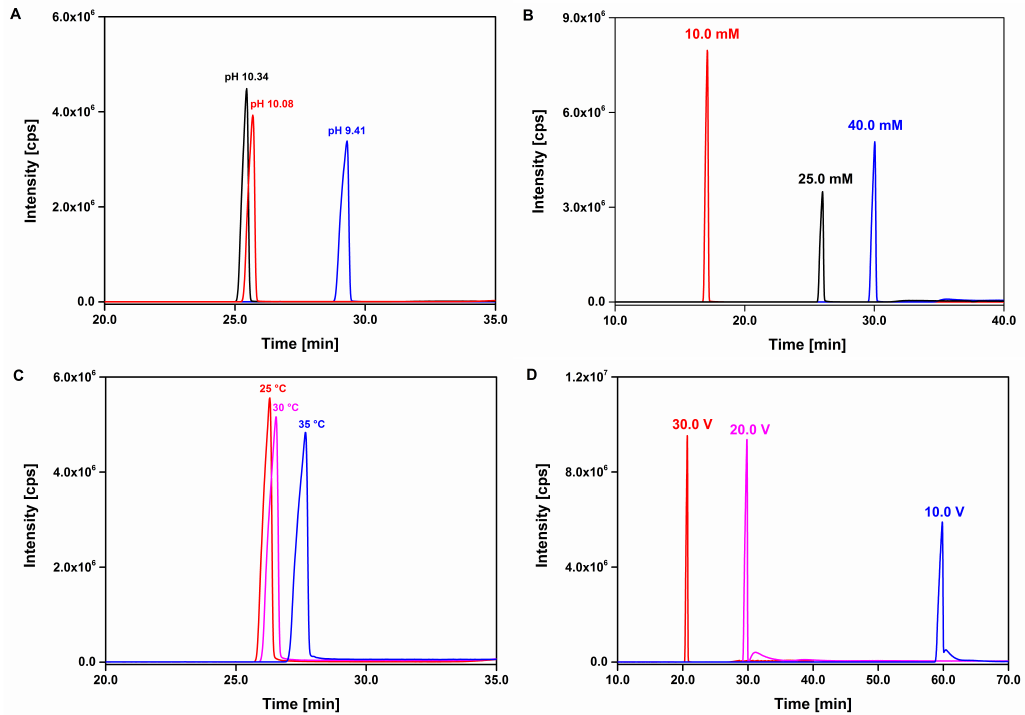
Figure 2. Electropherograms showing the TFSI − peak using an acetate buffer during method development: ( A ) measured at different pH values; ( B ) measured with different concentrations of the acetate buffer; ( C ) measured at different temperatures and ( D ) measured under different applied